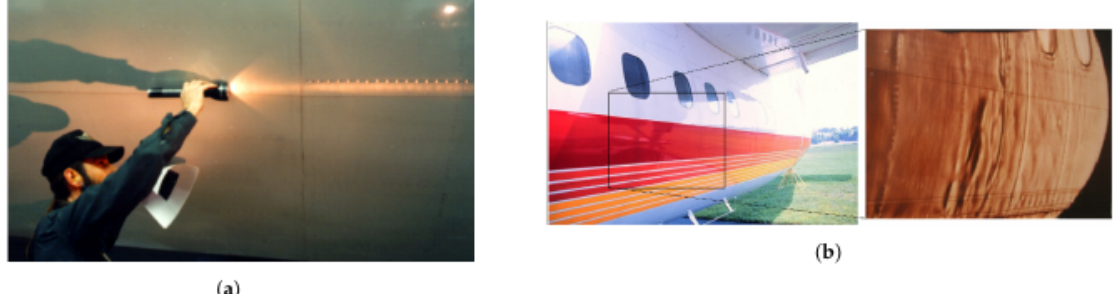
Figure 1. An example showing pillowing corrosion and surface micro deformations. ( a ) A specialist using a flashlight per- forms fuselage visual inspection; ( b ) the fuselage photo scanned showing surface micro perturbations caused by